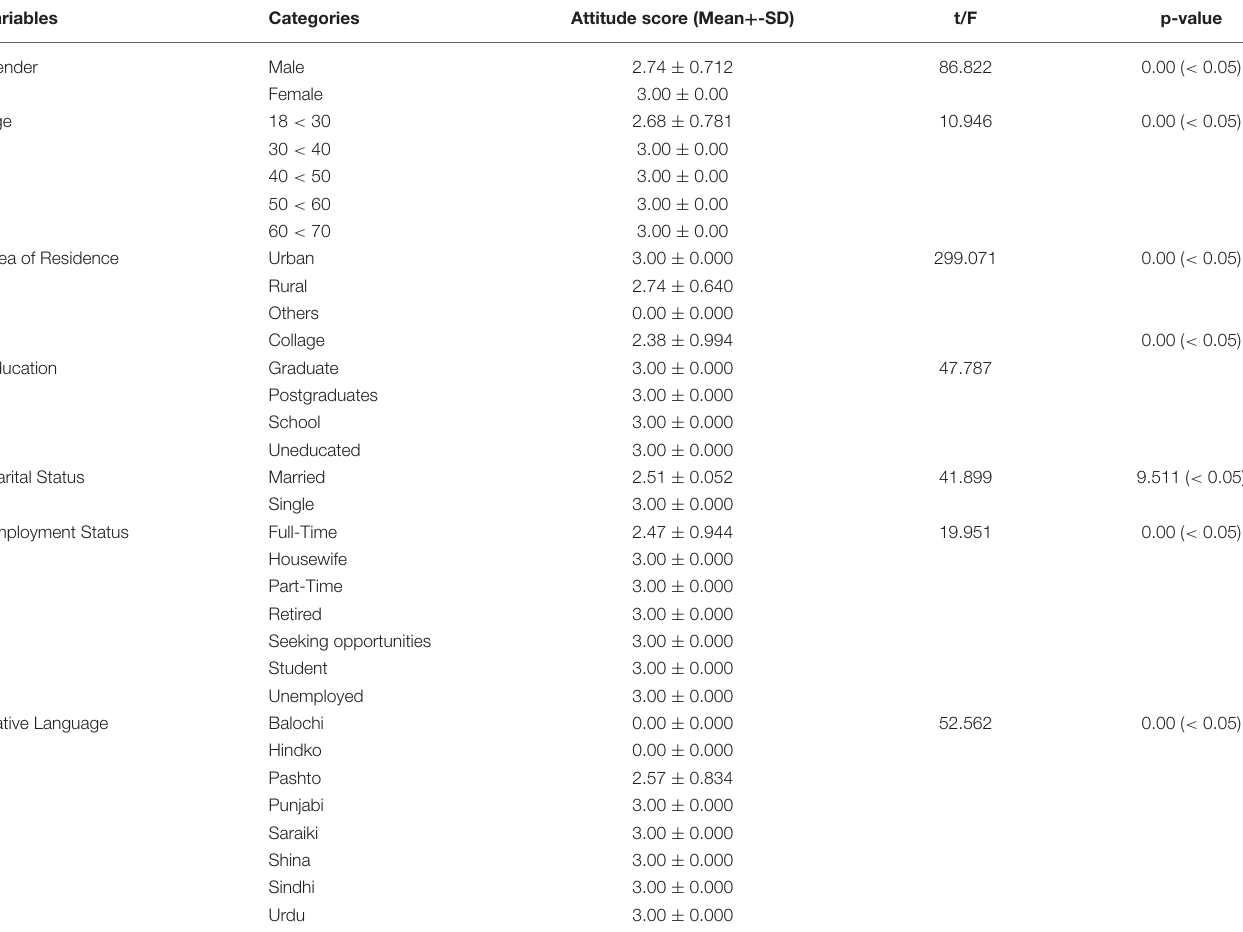
TABLE 7 | Association of attitude with demographic variables of respondents ( N = 734).